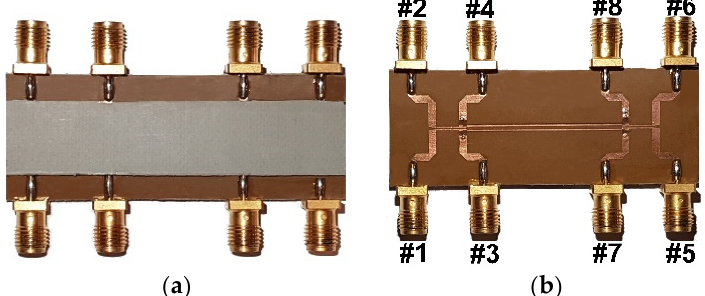
Figure 7. Photograph of the manufactured 3 ‐ dB differentially ‐ fed directional coupler (a), and the coupler with the top compensating dielectric layer removed, showing the coupled traces and ports’ labeling (b).